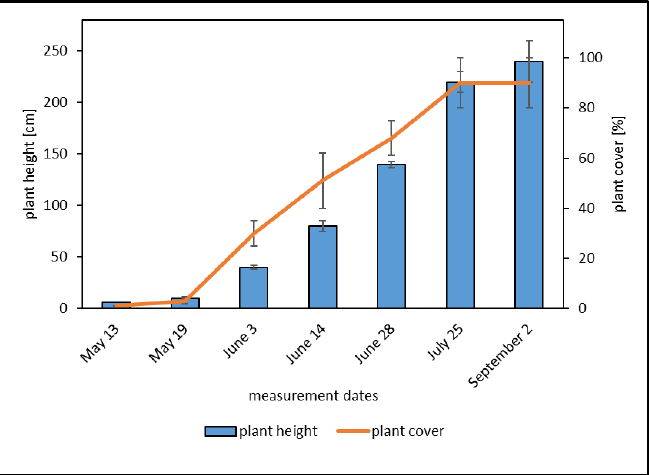
Figure 4. Vegetation development in the maize field.